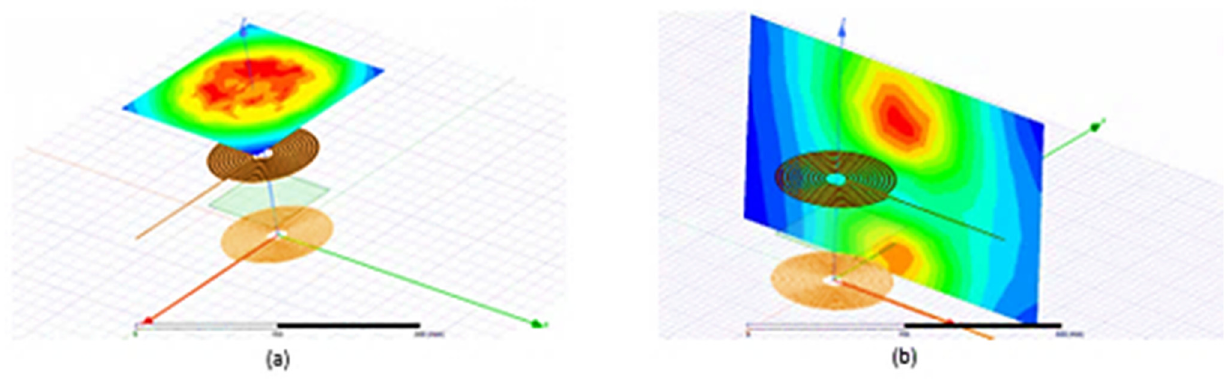
Figure 13. Magnetic flux density measurement configuration: ( a ) 400 mm upwards from the coil. ( b ) 200 mm away from the coils.